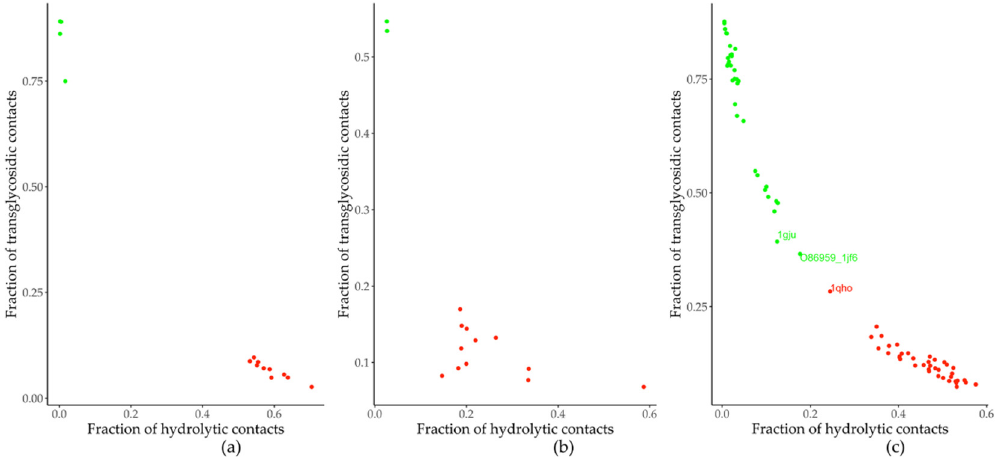
Figure 1. Function classification of enzymes in the GH13 family based on the amino acid preference in their residue-residue contacts. ( a ) Dataset 1 (training group). ( b ) Dataset 2 (validation group). ( c ) Dataset 4 (updated dataset). In both cases, enzymes defined as transglycosidic or hydrolytic are shown with green and red dots, respectively.